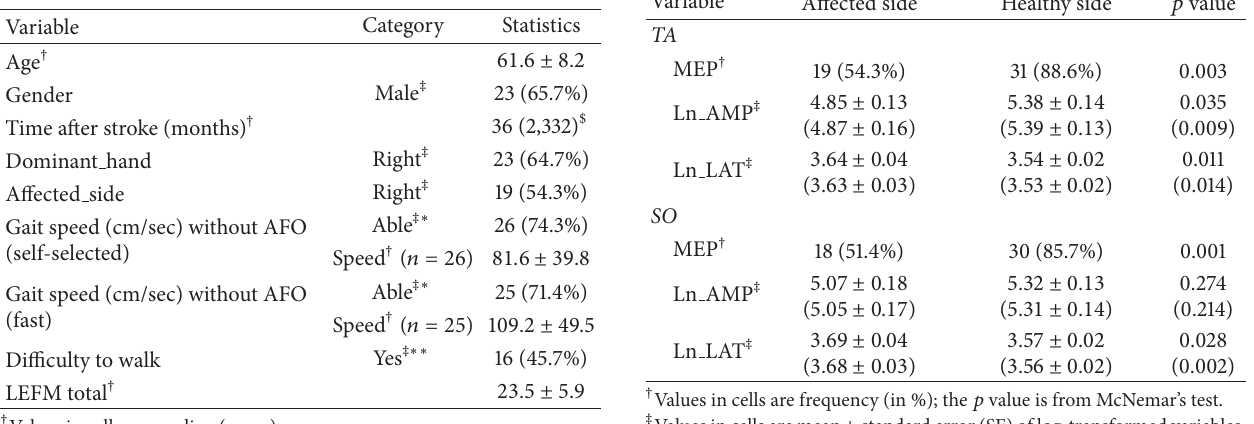
Table 1: Summary of demographics and baseline characteristics ( 𝑁 = 35 ).